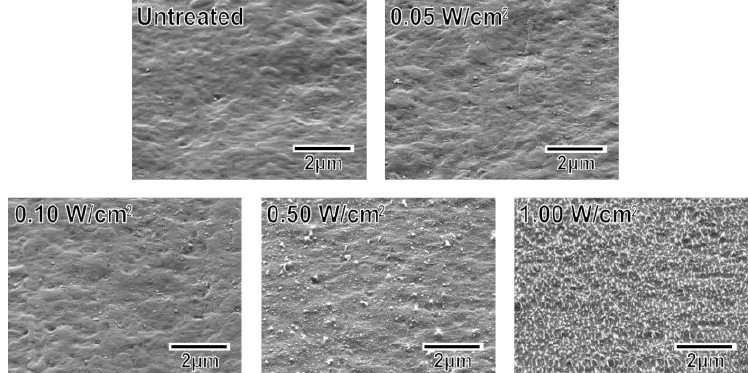
Figure 2. SEM images of the surfaces of the untreated and plasma-treated (0.05‒1.00 W/cm 2 ) plate specimens.